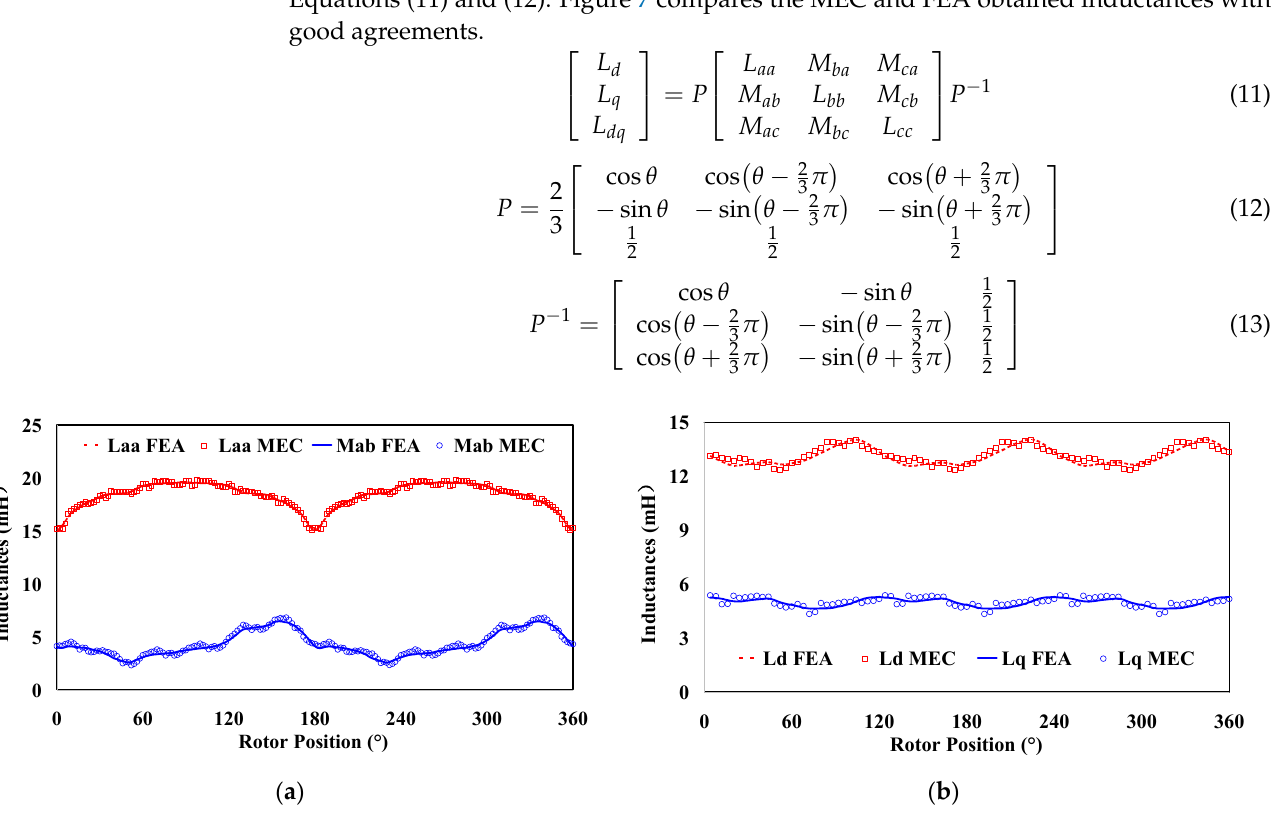
Figure 7. Comparison of the inductance results obtained by MEC and FEA. ( a ) Phase self and mutual inductances when 1 A is applied in phase-A. ( b ) d-axis and q-axis inductances at rated operation. It should be noted that in the 12/4 SynRM with concentrated windings, there is a cross-coupling between the d-axis and q-axis, i.e., the L dq contributes unneglectable electromagnetic torque, as given in Equation (14).